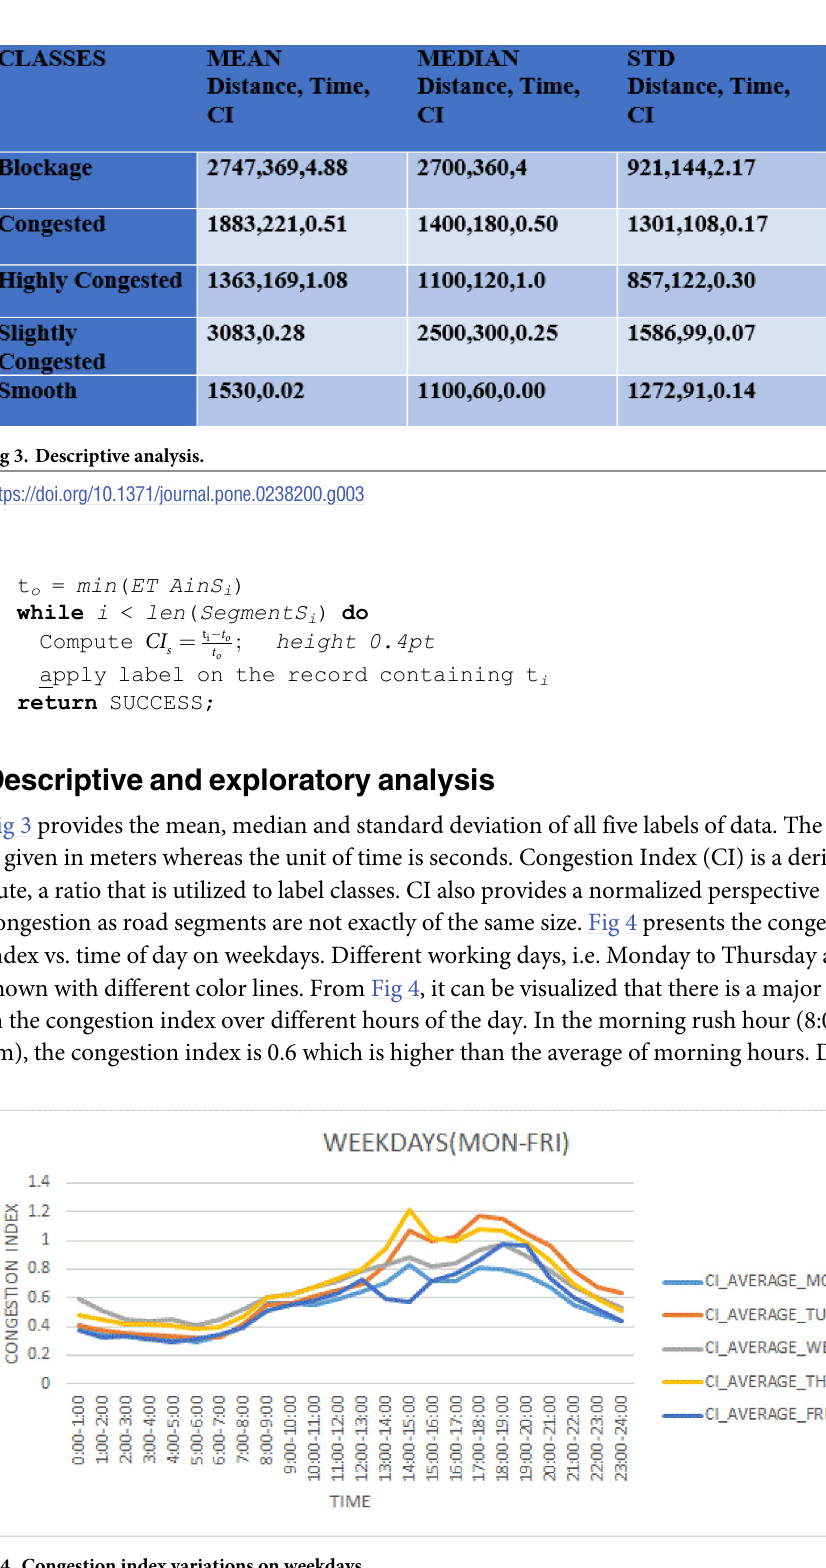
Fig 4. Congestion index variations on